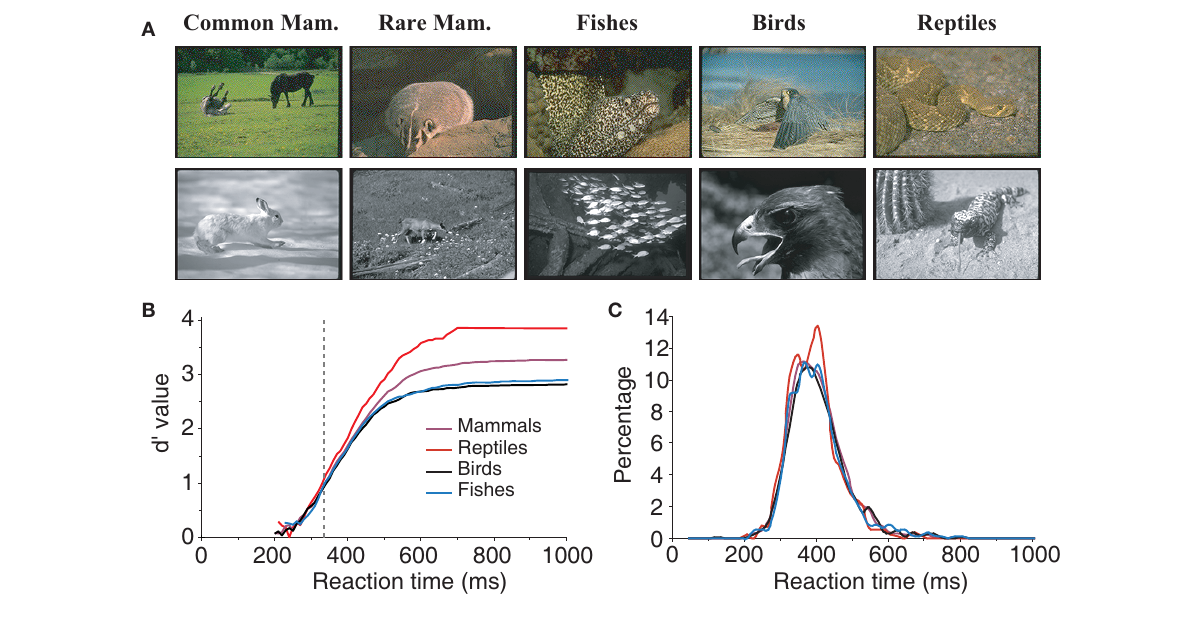
analysis. (B) Variation of subject accuracy with time for different classes of images. Accuracy is best for the reptile class. The vertical dotted line at 335 ms indicates the earliest latency at which the reptile category differs from the mammal category. (C) Reaction time distributions for the different classes of